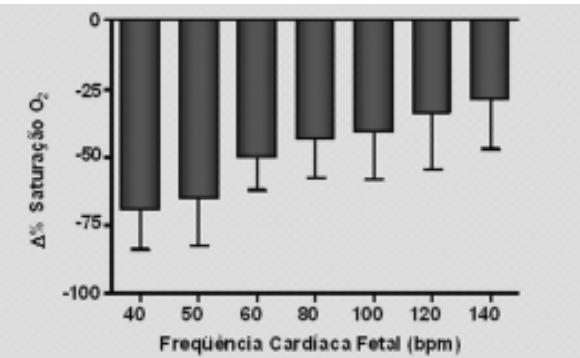
Fig. 5B - Relação da variação porcentual da saturação de oxigênio fetal com a freqüência cardíaca fetal. n = 4, Valores = média ± desvio